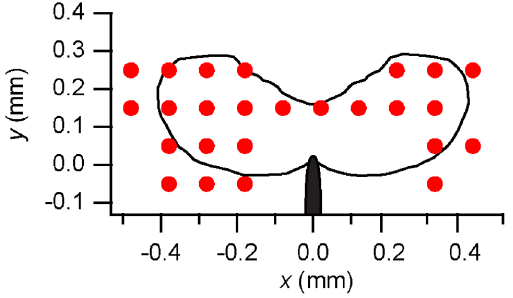
Figure 6. Points for which the von Mises stress is at the plateau value (Fig. 5) for a specimen loaded to K I ~ 76 MPam 1 = 2 at 298 K. Also shown is the shape of the plastic zone from a finite element model for n ~ 0 : 36 from Ref. [24].